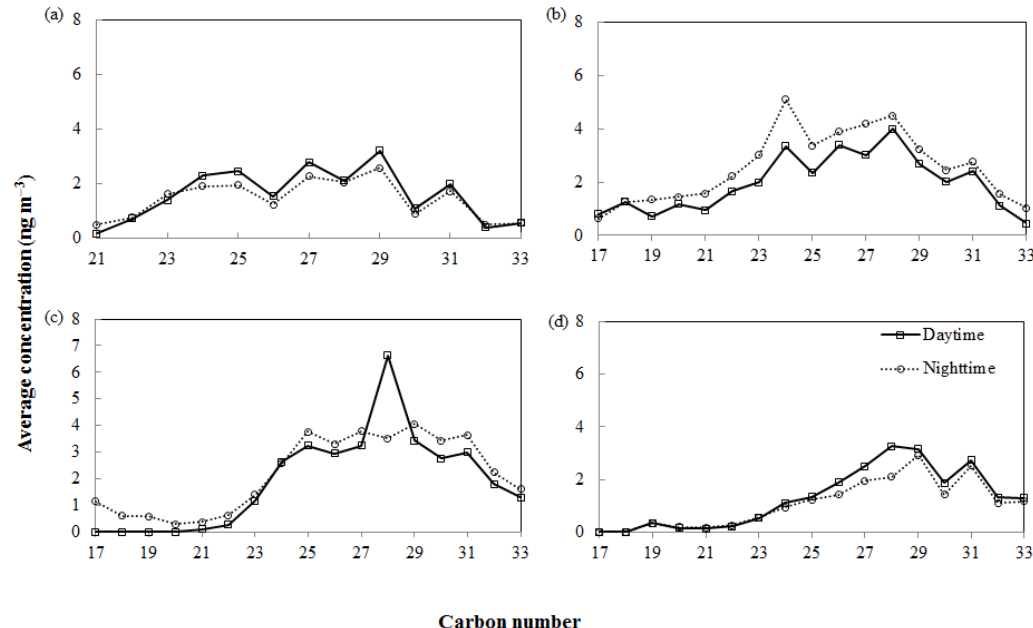
Figure 3. Carbon number distribution of n -alkanes in the Monterrey metropolitan area (MMA) for (a) spring 2011, (b) fall 2011, (c) spring 2012, and (d) fall 2012. The black line represents the daytime concentrations, while the dotted line represents the nighttime